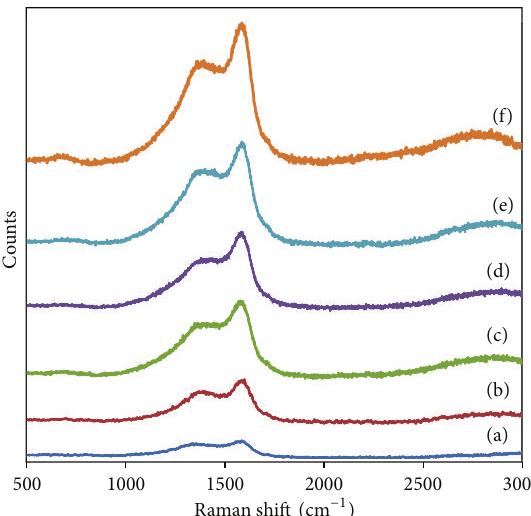
Figure 8: Raman spectra of HNO 3 functionalized 𝛼 CNTN/Ag nanohybrids at different molars of AgNO 3 : (a) 0 M, (b) 0.01 M, (c) 0.05 M, (d) 0.1M, (e) 0.5 M, and (f) 1M.